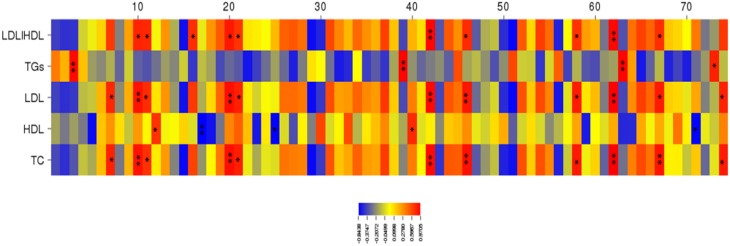
Correlations heat map demonstrating the association between the abundances of different cecal microbial species and plasma lipid parameters. Correlation coefficients are represented by color ranging from blue, negative correlation, to red, positive correlation. Significant correlations are noted by *p < 0.05 and **p < 0.01.